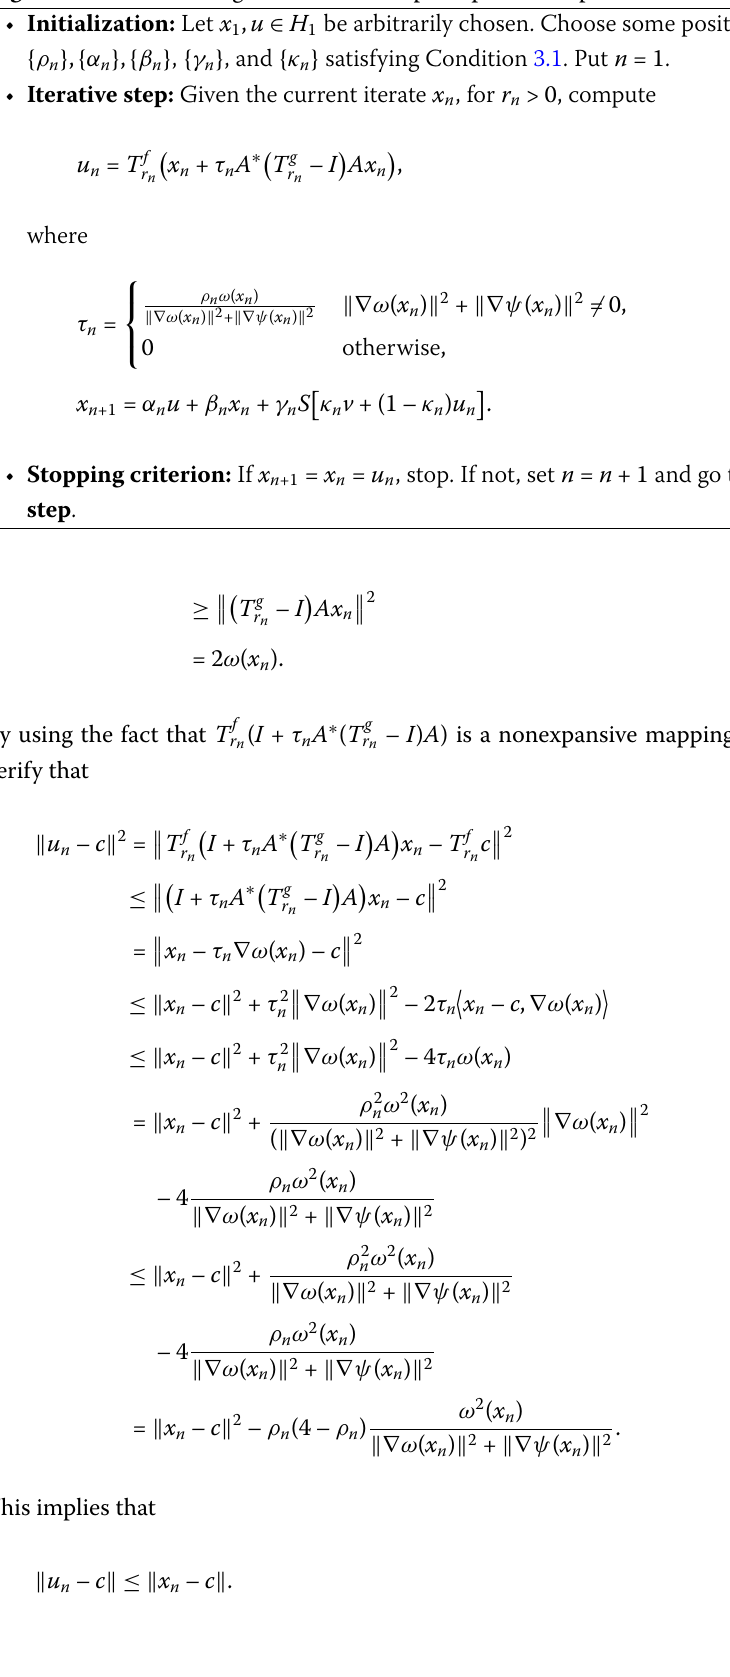
Algorithm 1 The first algorithm to solve split equilibrium